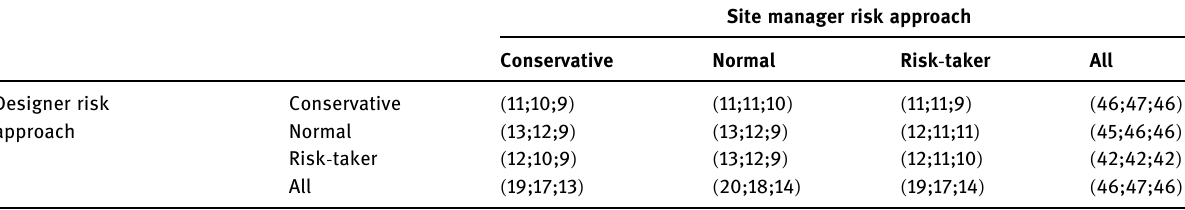
Table 7: Average standard deviation for project completion time ( days ) for various worker experience ratings ( little; average; high